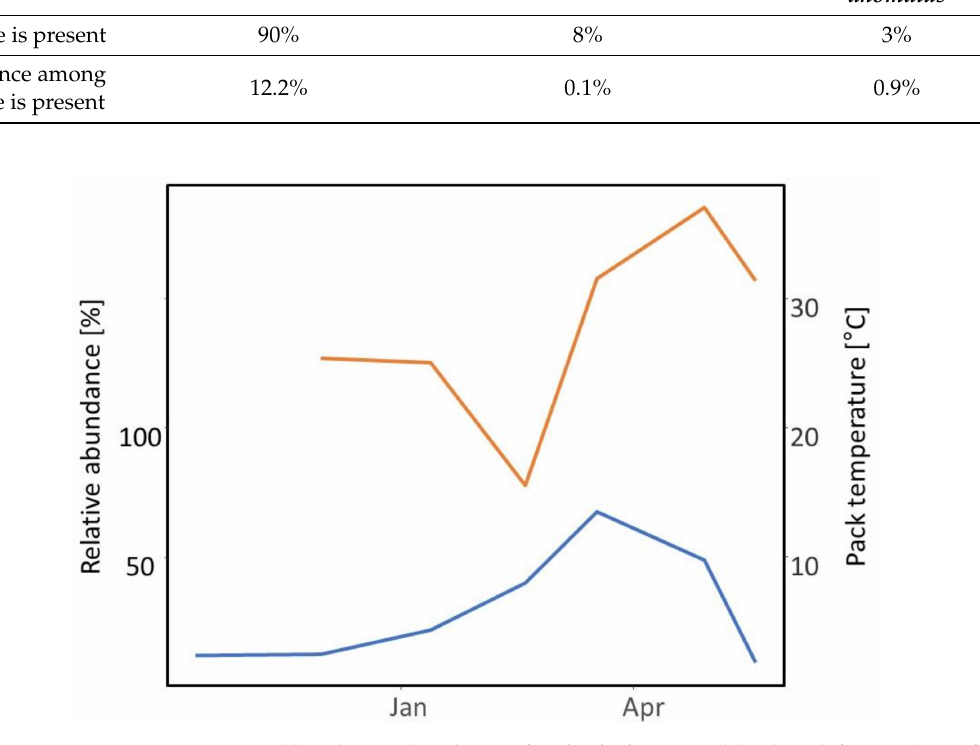
Figure 5. Mean monthly relative abundance of Pichia kudriavzevii (blue line, left y -axis) as a function of bedding temperature (orange line, right y -axis) in the oxic zone through time at Farm